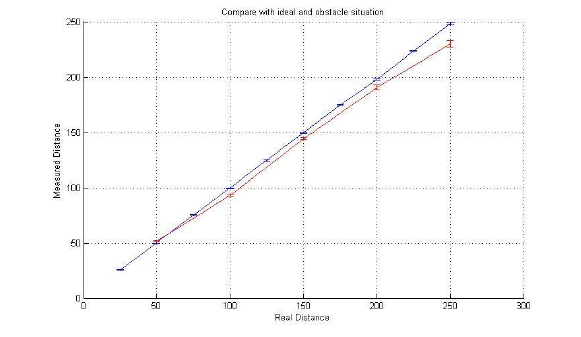
Figure 11. Real distance vs. measured distance